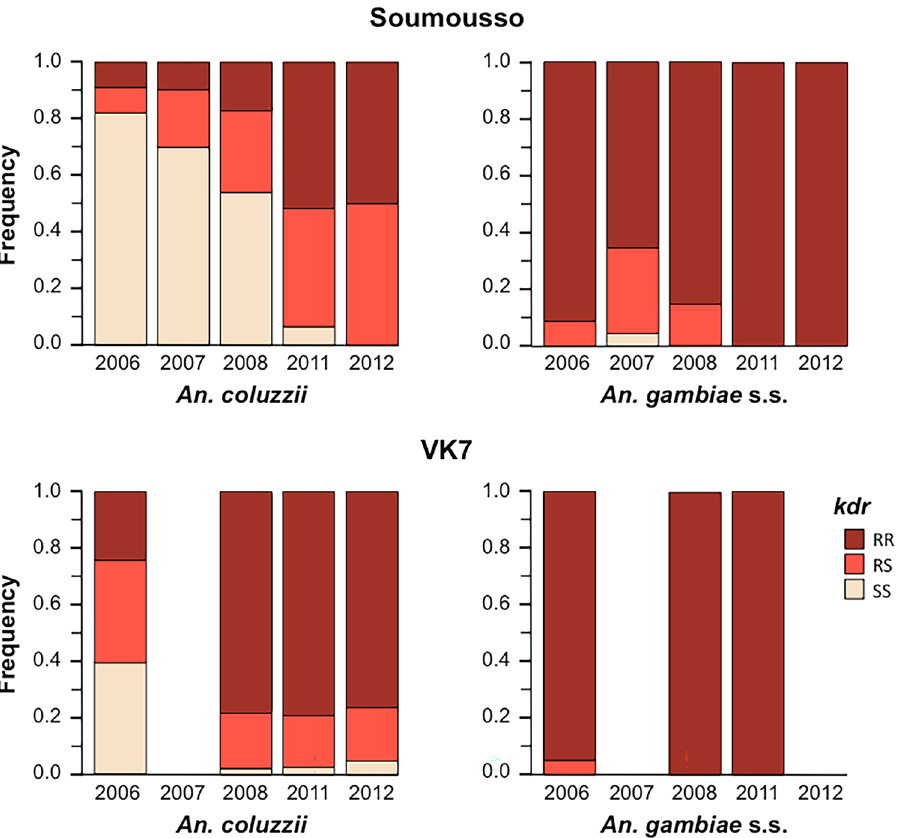
Figure 4. Changes in frequencies of introgressed kdr locus—The proportion of An. coluzzii individuals carrying the resistant allele (RR: homozygous kdr genotype or RS: heterozygous kdr genotypes) increased drastically from 2006 to near fixation in 2012 due to selective introgression of the 2L island from An. gambiae . The proportion of An. coluzzii individuals carrying the susceptible allele (SS: homozygous susceptible genotype) decreased over the same period.